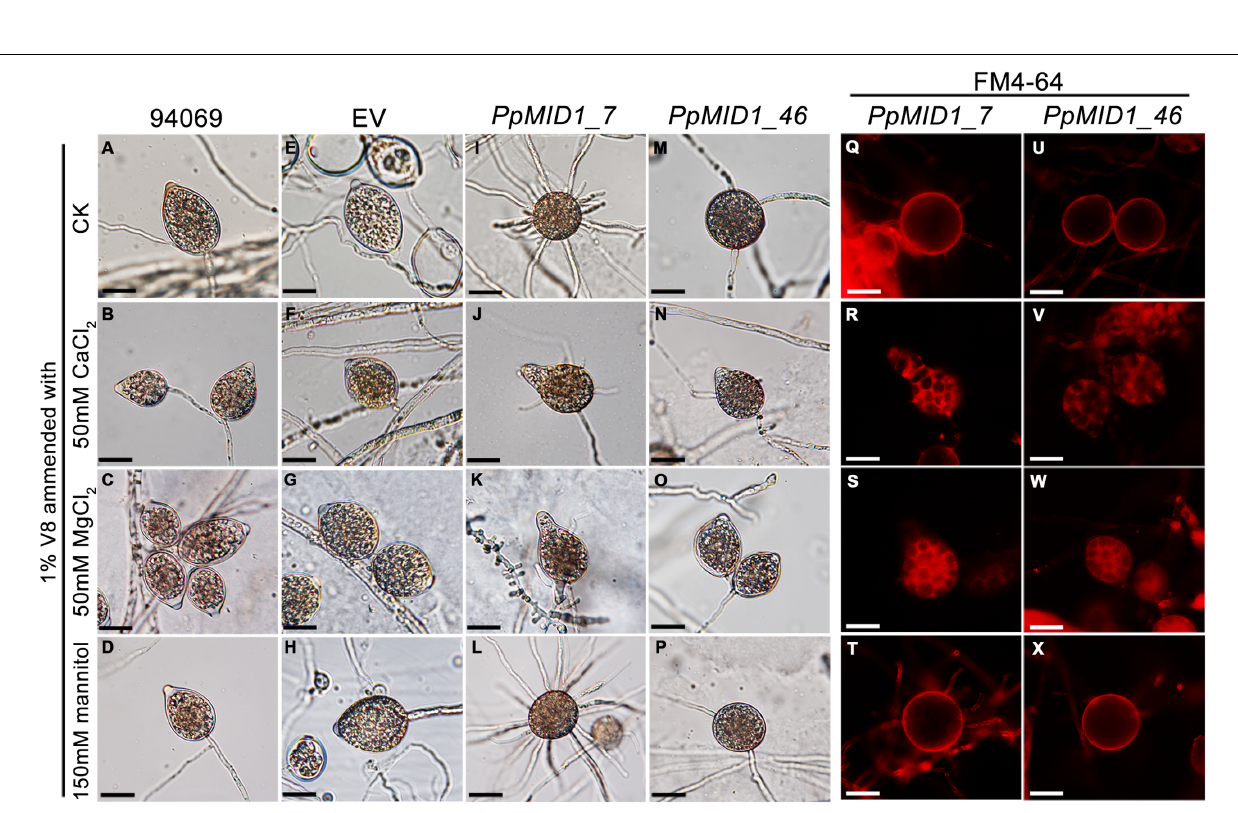
Frontiers in Microbiology |